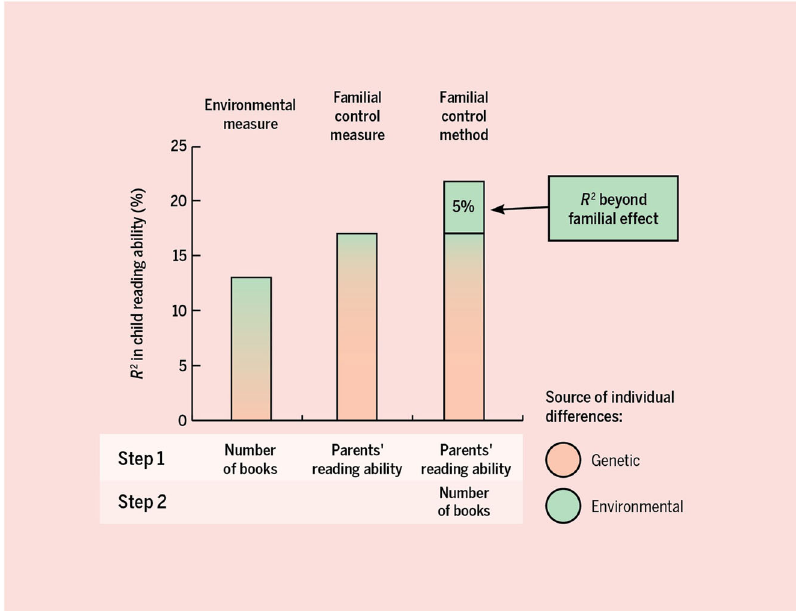
Fig. 8 Visualization of the Familial Control Method, in which a child outcome is predicted in a step-wise regression, with in the fi rst step the familial control measure (i.e., the trait in both parents) and in the second step the measure of the environment. The fi ndings that are depicted here come from van Bergen et al. 53 . The key question is whether the environmental measure explains variance beyond the familial effect, as this indicates a genuine environmental effect. In the example given, this was 5% and signi fi cant. This was negligible and non- signi fi cant for the other environmental measures reported in ref. 53 . Figure by ref. 66 available at https://bit.ly/2Pfjelh under a CC BY 4.0